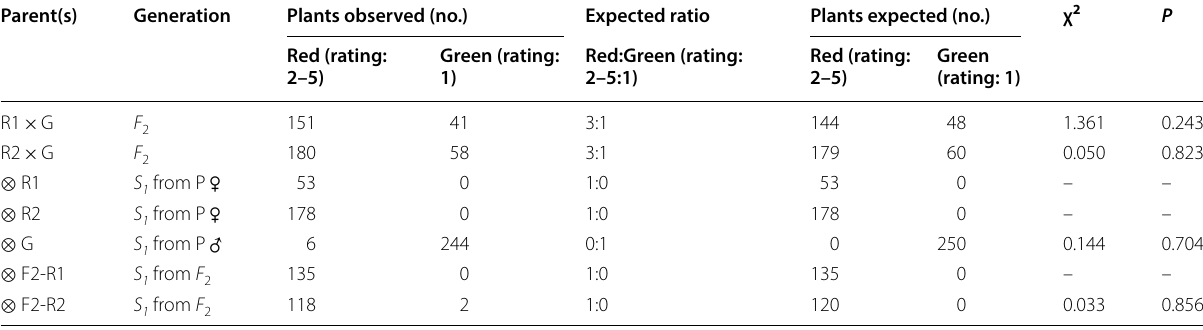
Table 1 Number of observed and expected plants for foliage color with corresponding Chi square and P values, where χ 2 0.05,1 =